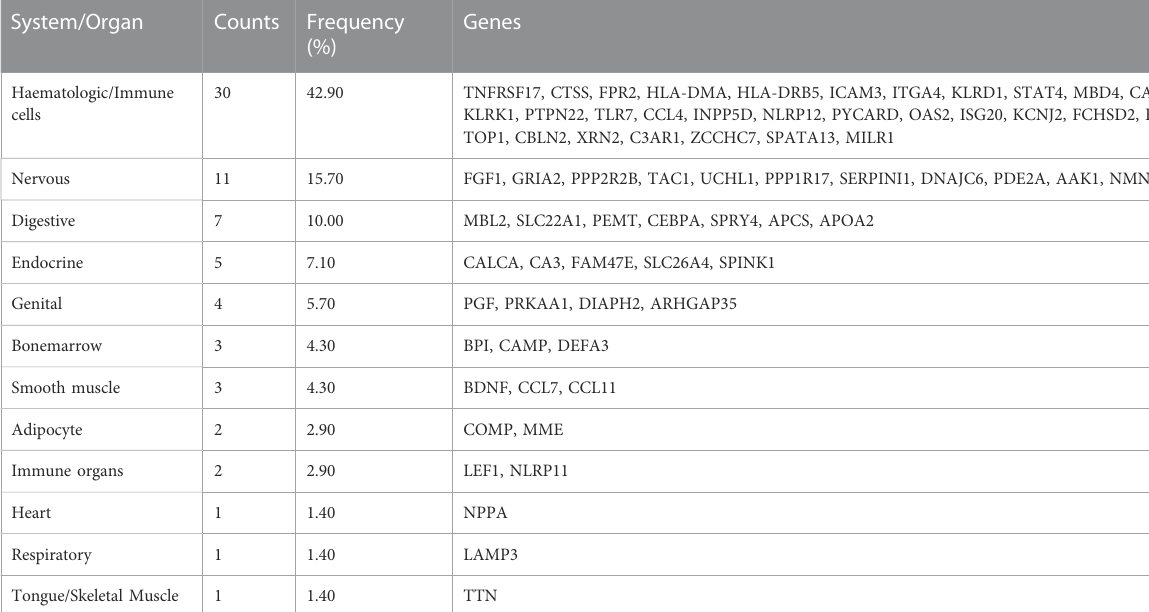
TABLE 1 70 Identi fi ed tissue/organ-speci fi c expressed genes by BioGPS.